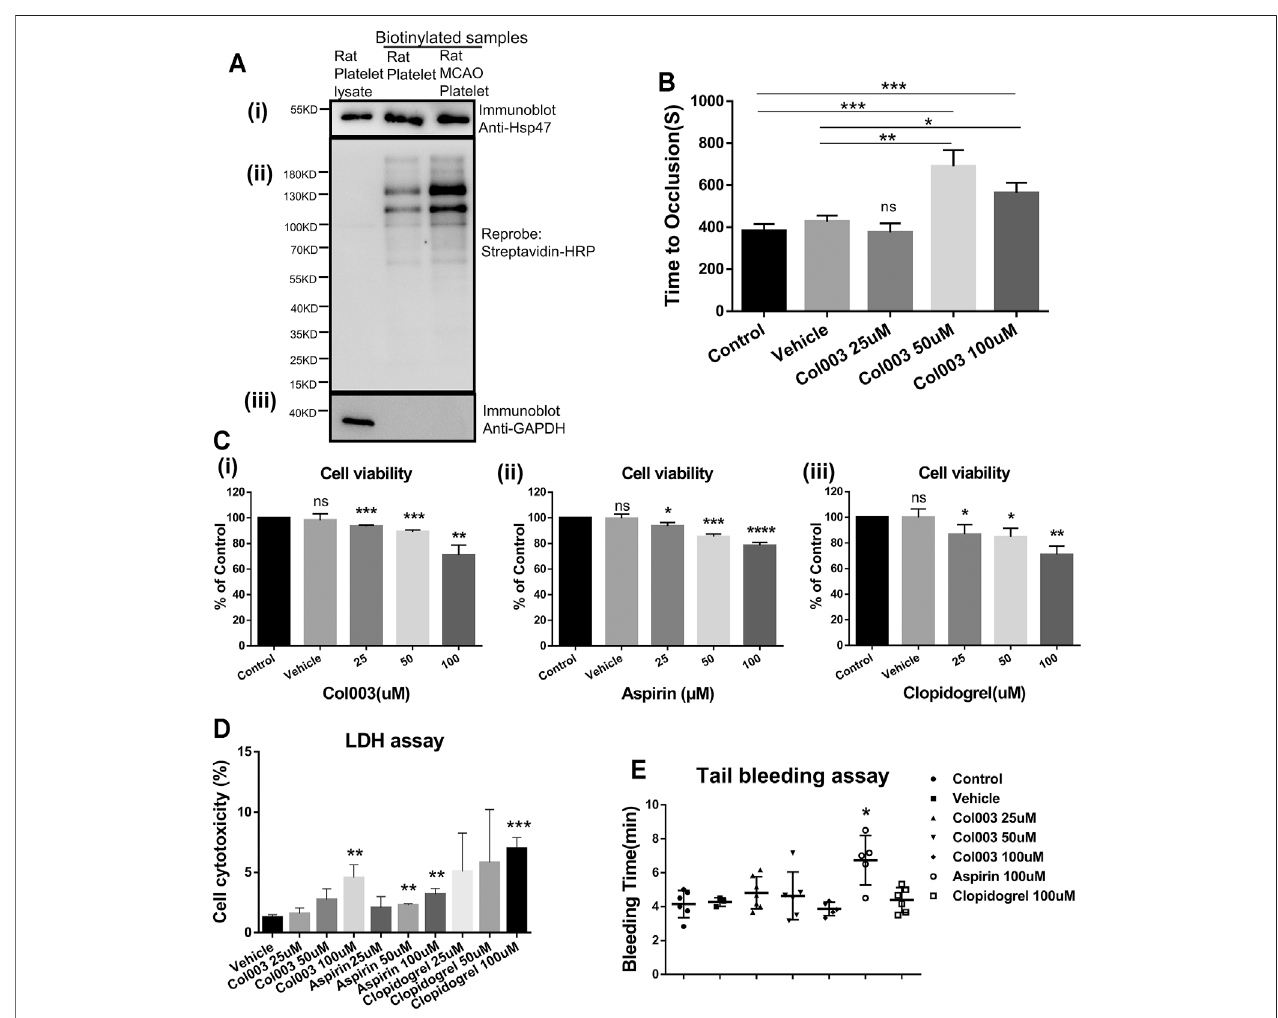
FIGURE 1 | Hsp47 is present at the platelet surface both in normal and MCAO rats, and its inhibitor Col003 attenuates thrombus formation. Col003 had low cytotoxicity on L02 cells and rat platelets without altering the tail-bleeding time in rats. (Ai) Biotinylated platelet surface proteins were assessed by immunoblots probed using anti-Hsp47 antibody. (Aii) Reprobing the immunoblot with horseradish peroxidase – conjugated streptavidin antibody was conducted to reveal total biotinylation. (Aiii) Immunoblotswerealso reprobed forGAPDH(a cytosolic protein)tocon fi rm thatthe biotinylation wasexclusively ofcellsurface proteins. (B) TTO(s)following FeCl 3 -induced injury of the carotid artery was recorded in different groups. TTO in the fi ve groups were 381.8 ± 14.94 s (Control), 426.3 ± 16.70 s (Vehicle), 375.0 ± 25.03 s (Col003 25uM), 689.3 ± 45.41 s (Col003 50uM), 562.7 ± 28.42 s (Col003 100uM), respectively. n (cid:1) 3 – 5; * p < 0.05, ** p < 0.01 and *** p < 0.001. (C) The cell viabilityofL02cellsafterincubationwithCol003(i),aspirin(ii)andclopidogrel(iii)for24 hwasdetectedbyCCK-8assay.ThecellviabilityofL02cellsinCol003groupwere 98.10 ± 2.89%(Vehicle),93.42 ± 0.53%(25uM),89.22 ± 0.77%(50uM),70.90 ± 4.59%(100uM),respectively.ThecellviabilityofL02cellsinaspiringroupwere99.53 ± 1.93% (Vehicle), 93.57 ± 1.60% (25uM), 85.39 ± 1.19% (50uM), 78.53 ± 1.31% (100uM), respectively. The cell viability of L02 cells in clopidogrel group were 99.95 ± 3.73%(Vehicle),86.76 ± 4.34%(25uM),84.76 ± 3.86%(50uM),71.00 ± 3.79%(100uM),respectively.* p < 0.05,** p < 0.01,*** p < 0.001,and**** p < 0.0001(vscontrol). (D) Cytotoxicity in different groups was detected via LDH assay. The cytotoxicity in different groups were 1.27 ± 0.13% (Vehicle), 1.59 ± 0.27% (Col003 25uM), 2.75 ± 0.52% (Col003 50uM), 4.56 ± 0.63% (Col003 100uM), 2.07 ± 0.54% (Aspirin 25uM), 2.29 ± 0.07% (Aspirin 50uM), 3.18 ± 0.29% (Aspirin 100uM), 5.08 ± 1.84% (Clopidogrel 25uM), 5.82 ± 2.55% (Clopidogrel 50uM), 6.97 ± 0.54% (Clopidogrel 100uM), respectively. ** p < 0.01 and *** p < 0.001 (vs vehicle). Statistical methods for TTO, cell viability and cytotoxicity using unpaired two-tailed Student ’ s t -test. (E) The effect of Col003 on tail-bleeding time in rats. The tail-bleeding time in seven groups were 4.15 ± 0.33 min (Control), 4.28 ± 0.15 min (Vehicle), 4.81 ± 0.36 min (Col003 25uM), 4.64 ± 0.56 min (Cl003 50uM), 3.87 ± 0.18 min (Col003 100uM), 6.73 ± 0.65 min (Aspirin 100uM), 4.39 ± 0.30 min (Clopidogrel 100uM), respectively. Statistical analysis was performed with the nonparametric Mann – Whitney U test ( n (cid:1) 3 – 7; * p < 0.05, vs